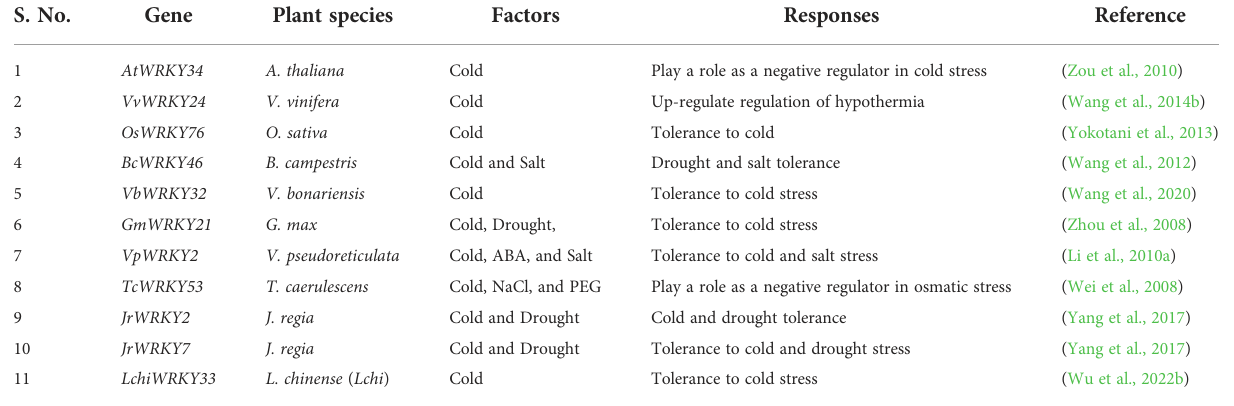
TABLE 4 Cold stress-related WRKY TFs. S.